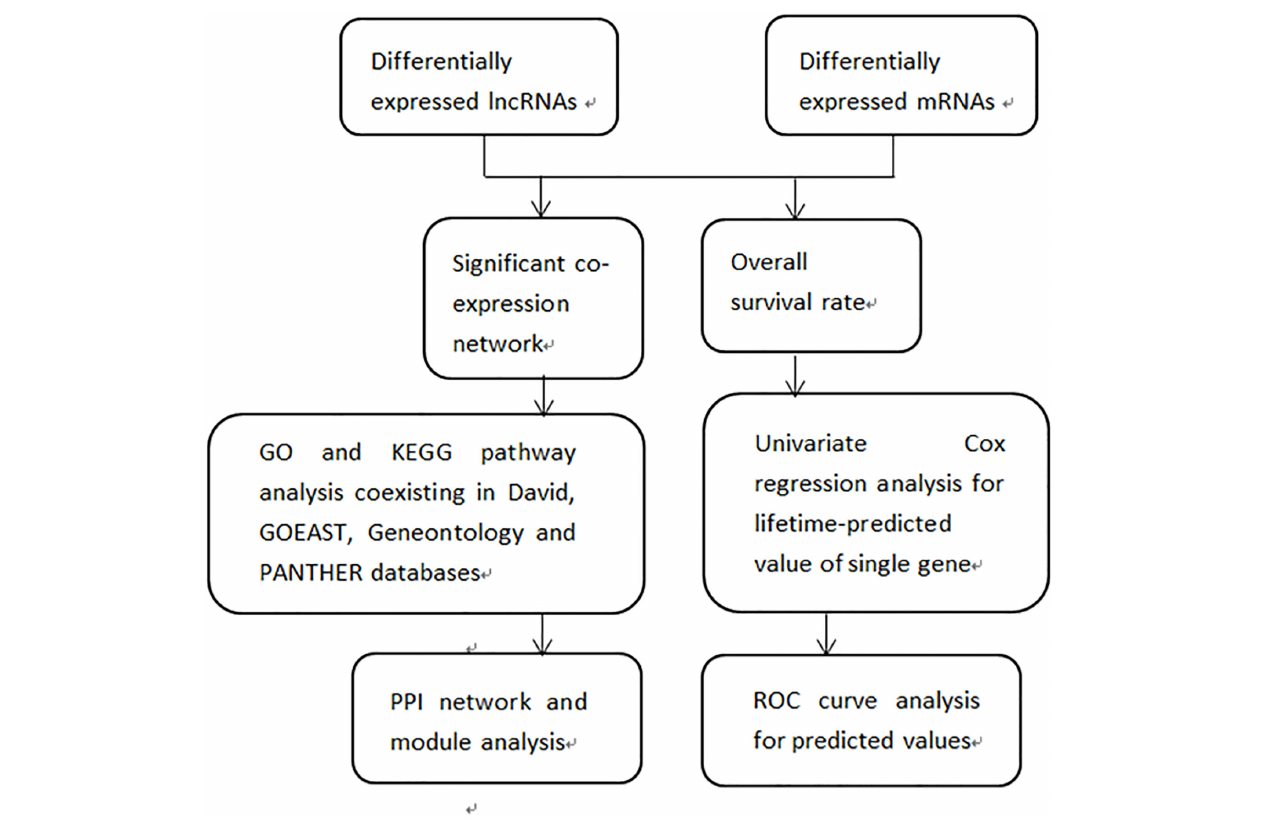
FIGURE 2 | Flow diagram of the study design. DElncRNAs and DEmRNAs were investigated between 103 primary and 368 metastatic melanomas (log2fold change > 2, FDR <